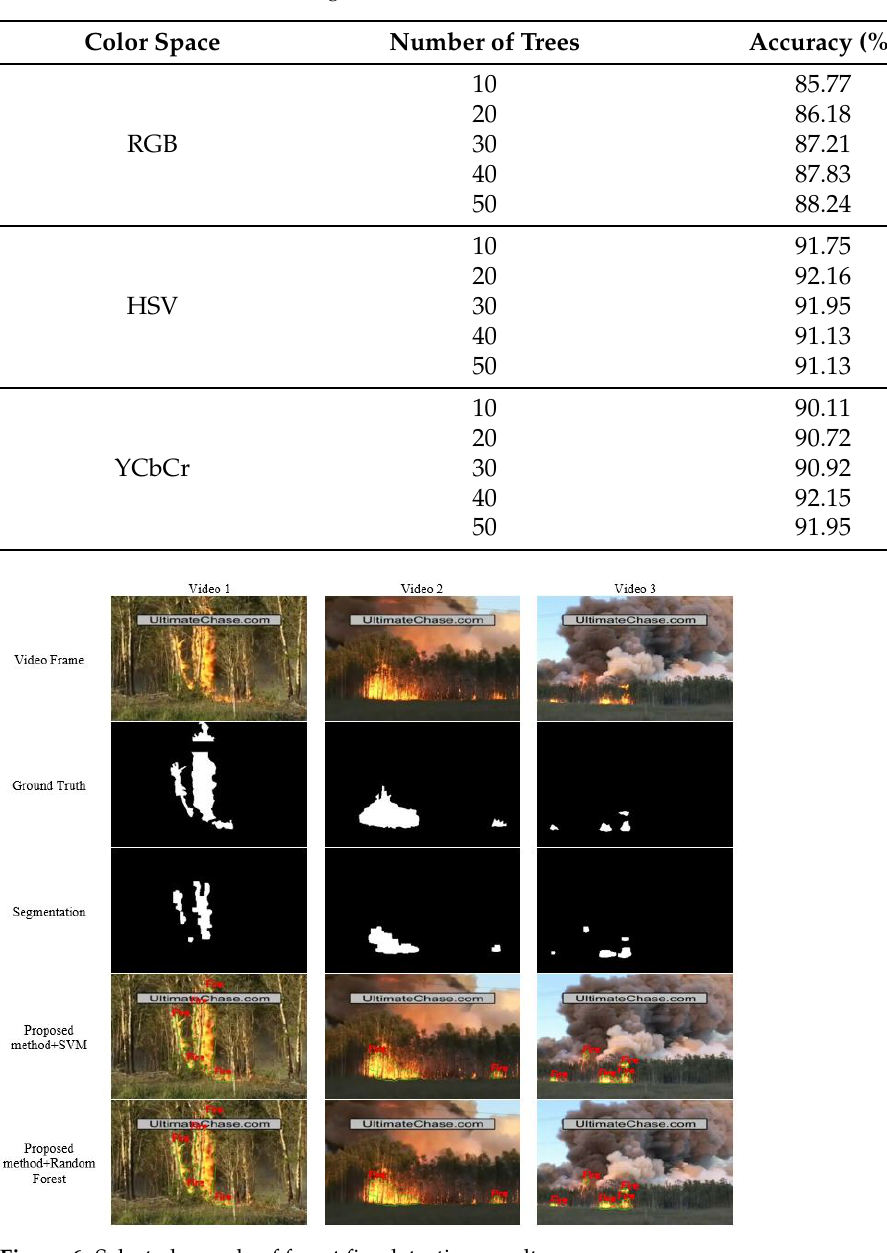
Figure 6. Selected sample of forest fire detection